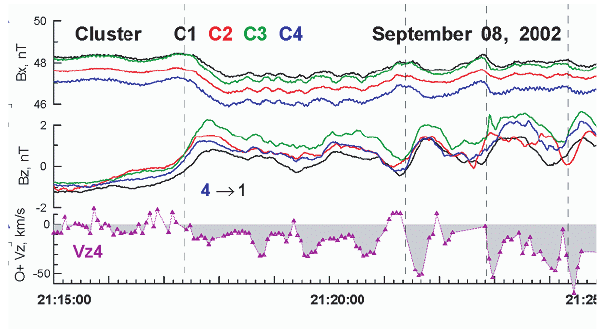
Fig. 11. Cluster observations near the plasma sheet outer bound- ary at substorm onset. Variations of the B x and B z components are shown together with vertical flow component of cold oxygen at spacecraft C4. Note the anticorrelation between B z and V z varia- tions and phase shifts between B x compressions (marked by ver- tical dashed lines) and B z variation. From cross-correlation these structures were found to propagate Earthward at ∼ 600km/s. (From Sergeev et al.,